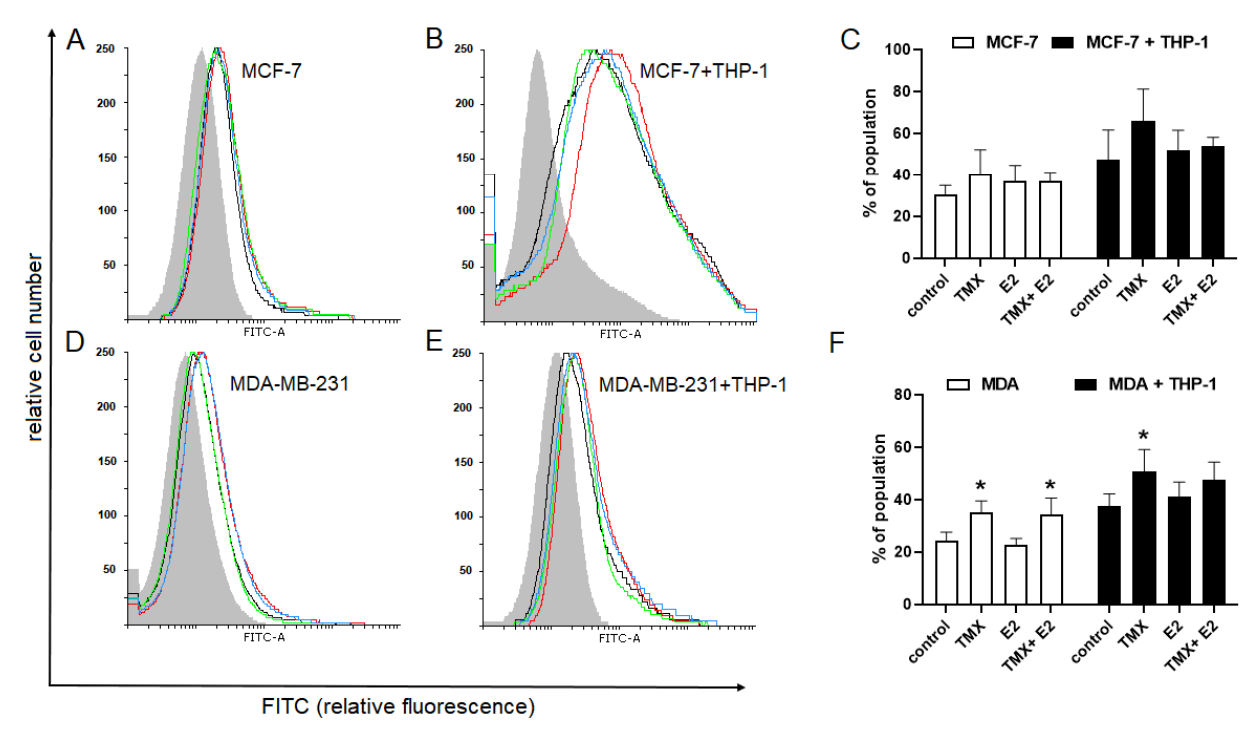
Figure 6. Effect of TMX and/or E2 on the binding of Siglec-14/Fc fusion protein to MCF-7 ( A , B ) and MDA-MB-231 ( D , E ) breast cancer cells grown in monocultures or co-cultures. Representative histograms and the corresponding bar graphs ( C , F ) show the isotype of the control (light grey filled histogram), the control cells (black line), TMX-treated cells (red line), E2-treated cells (green line) and cells concomitantly treated with TMX/E2 (blue line). Data are presented as the median percentage of each population (mean of 5 separate determinations). * p < 0.05 vs. the corresponding control group.